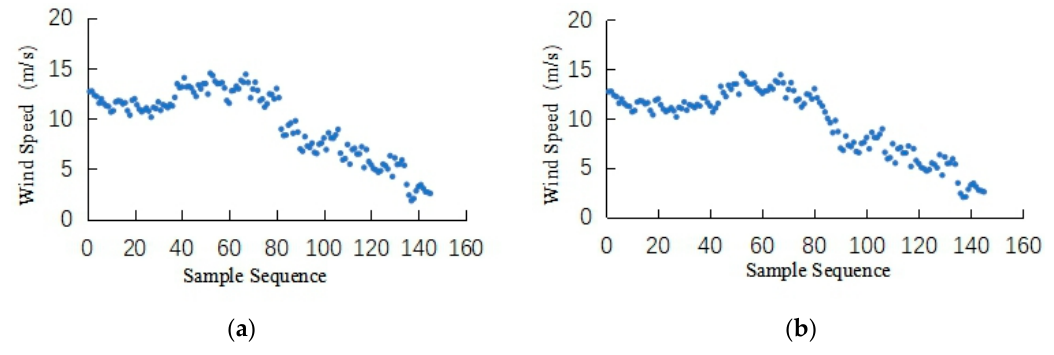
Figure 1. 2018-1-12 Data pretreatment by the Lomnaofski optimization model. ( a ) The data graph of original data; and ( b ) the data graph after being processed by the Lomnaofski optimization model.